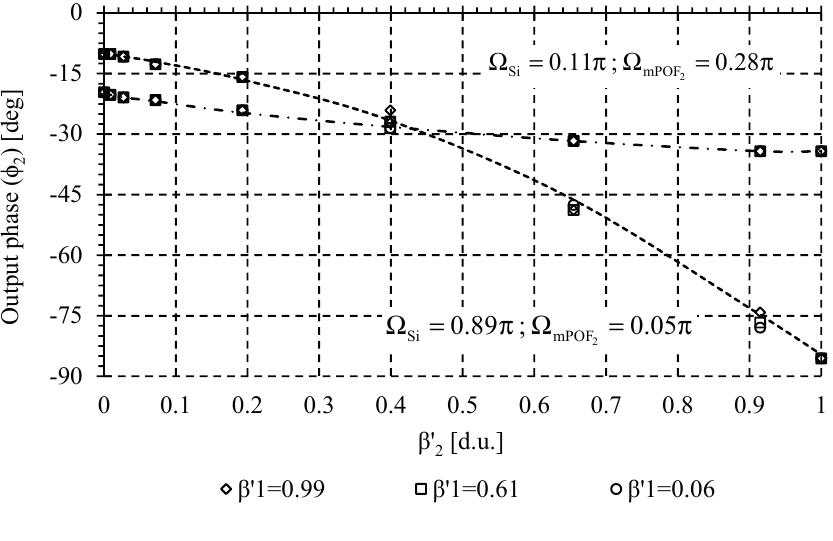
Figure 8. Crosstalk related measurements. Output phase parameter versus sensor loss at channel λ (FOS 2 ) for different values of sensor loss at channel λ (cid:2923)(cid:2900)(cid:2899)(cid:2890) (cid:2870)